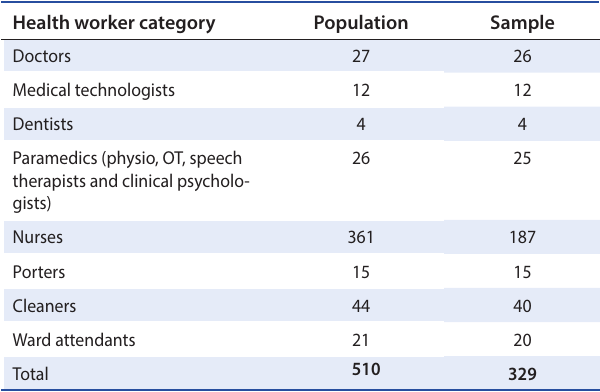
Table 1: Number of relevant staff members working at district hospital and sample selected Health worker category Population